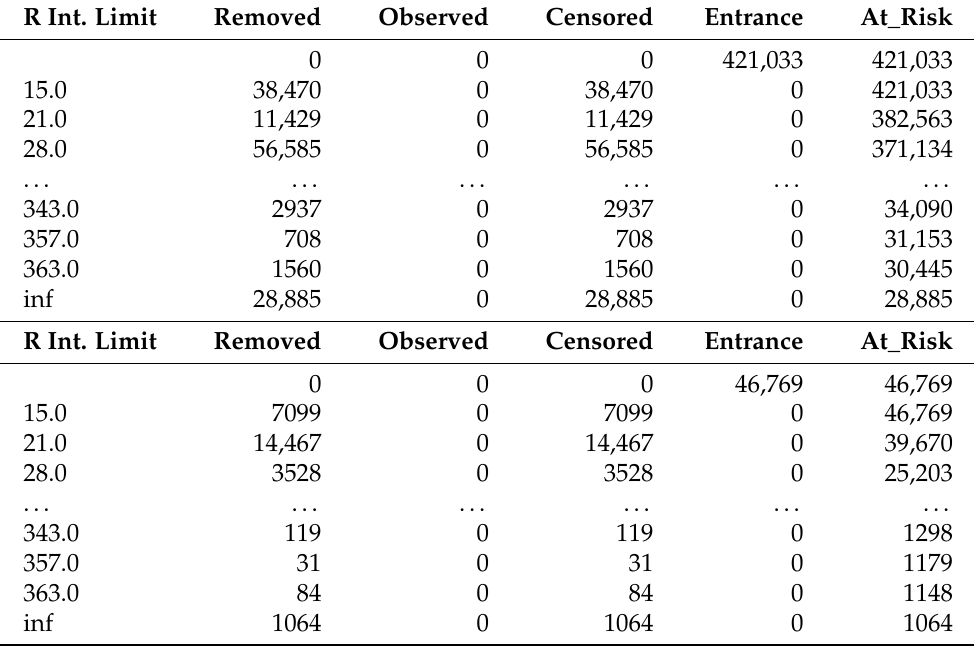
Table 4. Survival tables for location lifetime of IPv4 (above) and IPv6 addresses (below). R Int.